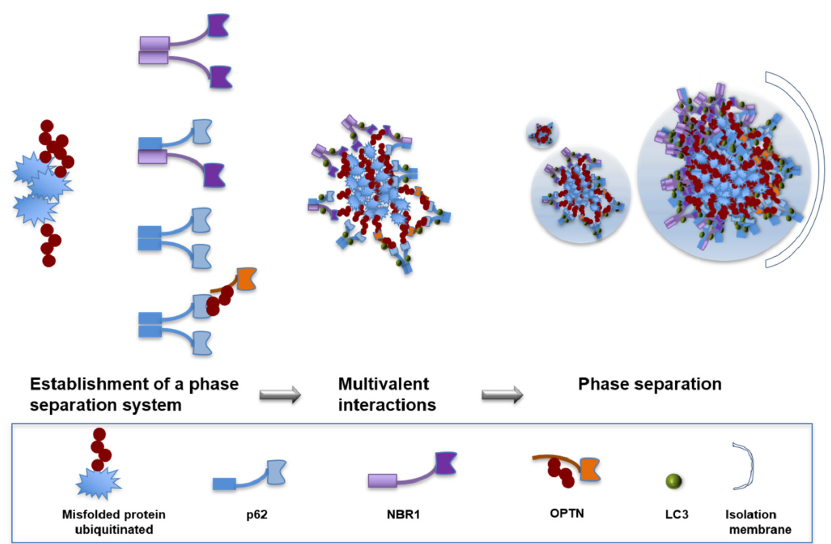
Figure 5. Autophagic cargo segregation through polyubiquitin chain-induced autophagy-receptor phase separation. p62 and NBR1 proteins form oligomers through the PB1 domain (mandarin blue and lavender rectangles) and bind to ubiquitin through the UBA domain (light blue part and deep violet parts). p62 can also bind to the polyubiquitin chains of autophagy receptor OPTN to form autophagy receptor complexes; thus, OPTN can form oligomers through the PB1 domain of